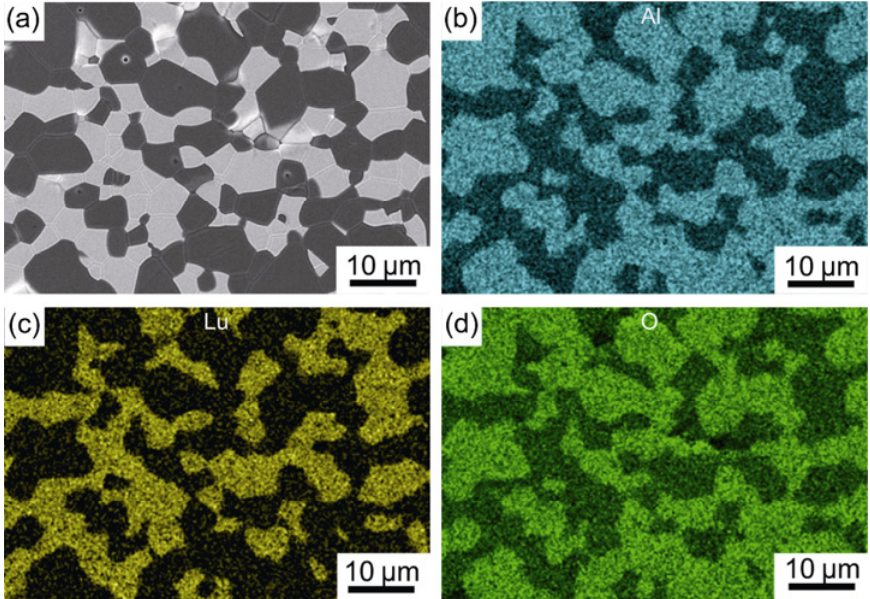
Fig. 3 (a) Local FESEM micrograph of 50 wt% LACCs and the corresponding elemental mappings of (b) Al, (c) Lu, and (d) O